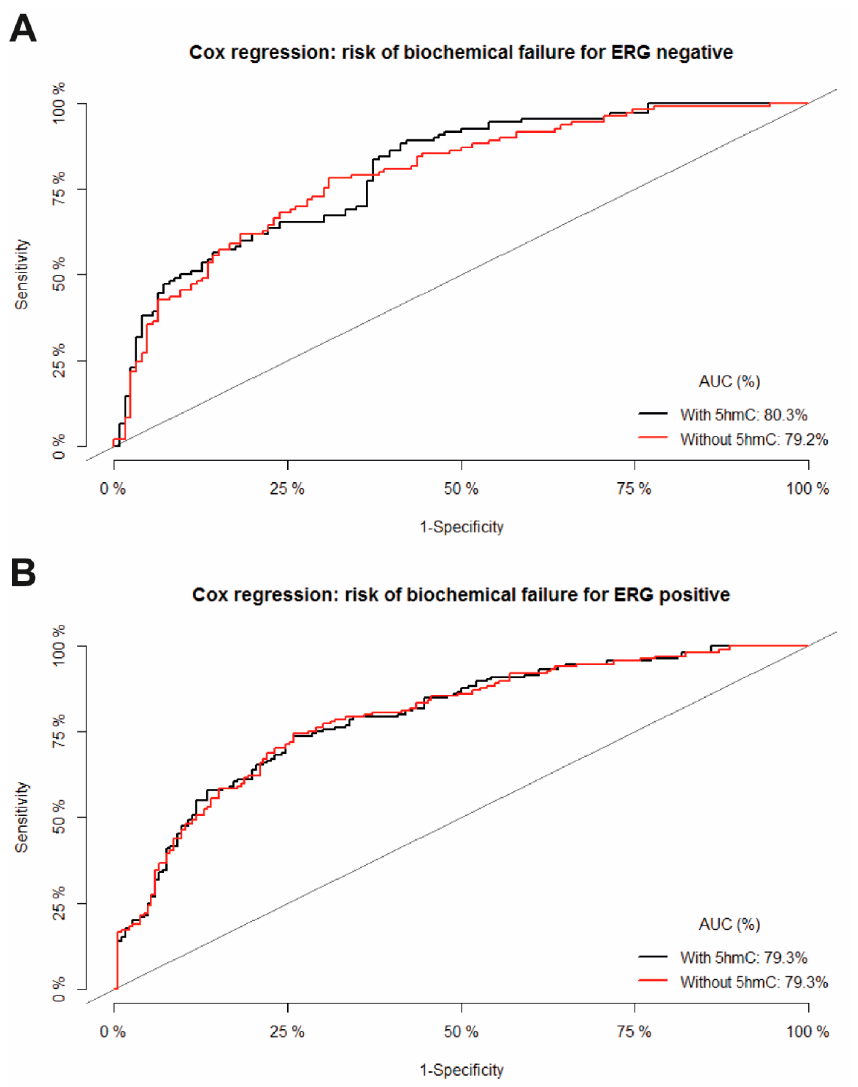
Figure 3. Receiver operating characteristic (ROC) curves for the multivariate cause-specific Cox regression model with and without 5hmC level for predicting biochemical failure of ( A ) ERG negative and ( B ) ERG positive patients. Area under the receiver operating characteristic curve (AUC) are